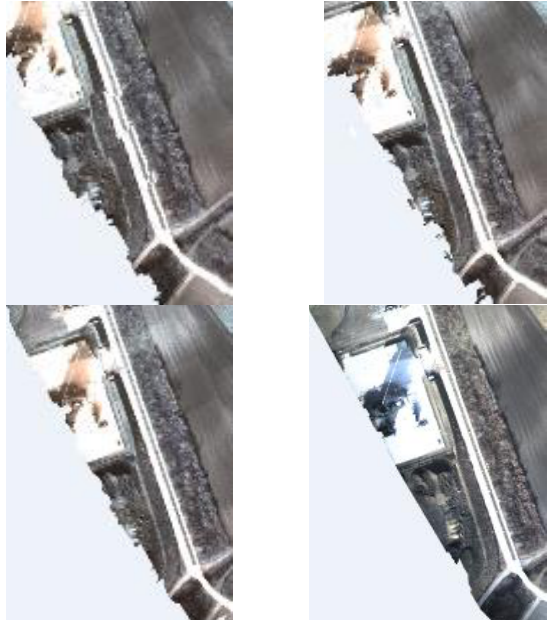
Figure 4 Comparison of an image detail between orthomosaics from the data set at 120 m. From the top left in clockwise order: OpenVSLAM, ORB-SLAM3, Pix4D reference data set processed with ground control and OV 2 SLAM